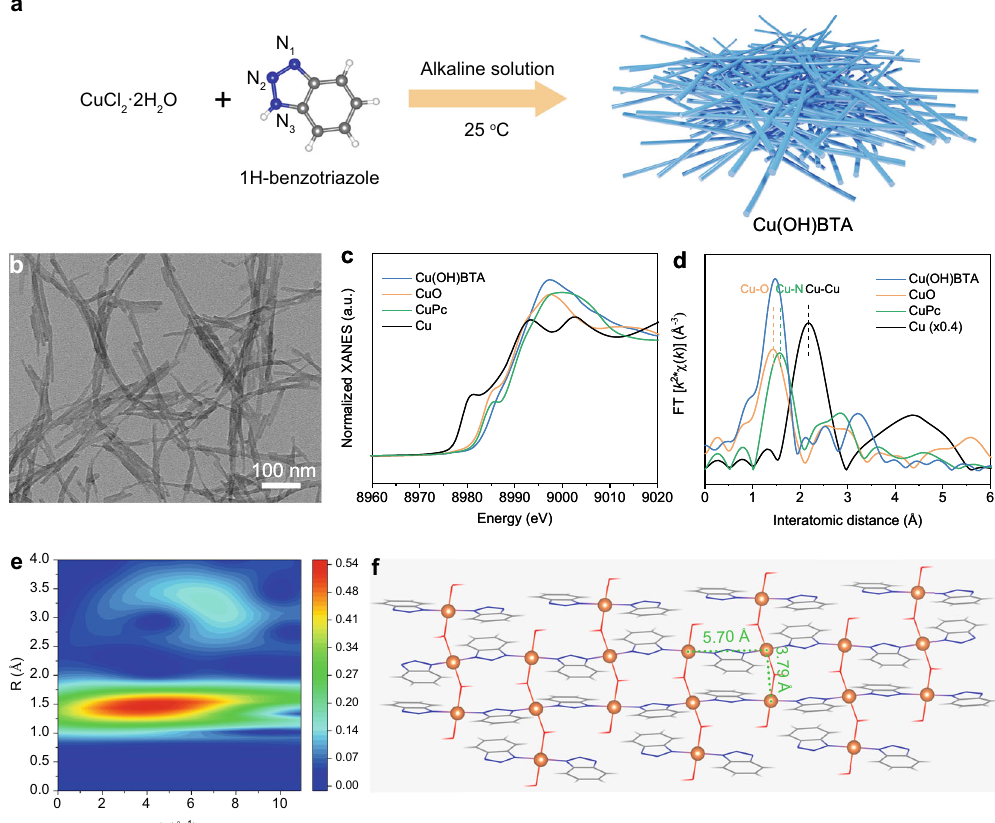
Fig. 1 | Preparation and structure characterization of Cu(OH)BTA. a Schematic illustration of the synthesis procedure. b TEM image of Cu(OH)BTA . Cu K-edge XANESspectrum( c )andEXAFSspectrum( d )ofCu(OH)BTA.TheCuK-edgeXANES spectra of Cu foil, CuO, and copper(II) phthalocyanine (CuPc) were used as